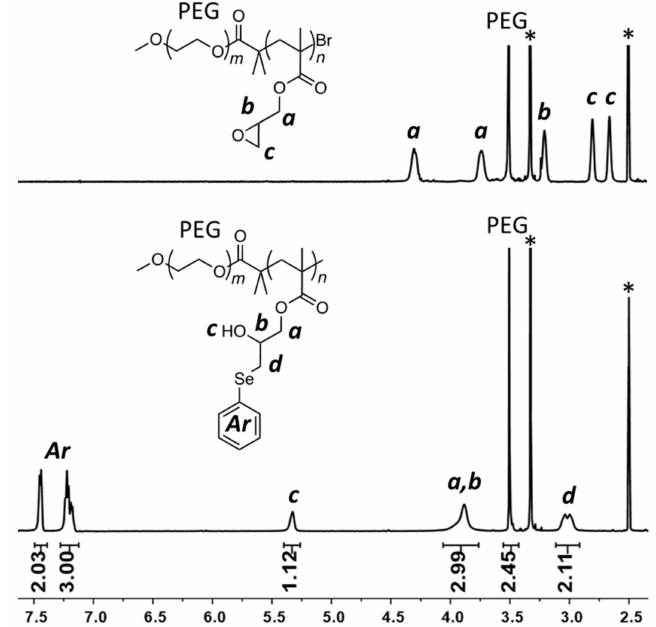
Figure 4. 1 H-NMR of 6 and 8 in DMSO- d 6 . The residual solvent signals from DMSO and water are shown with the help of an